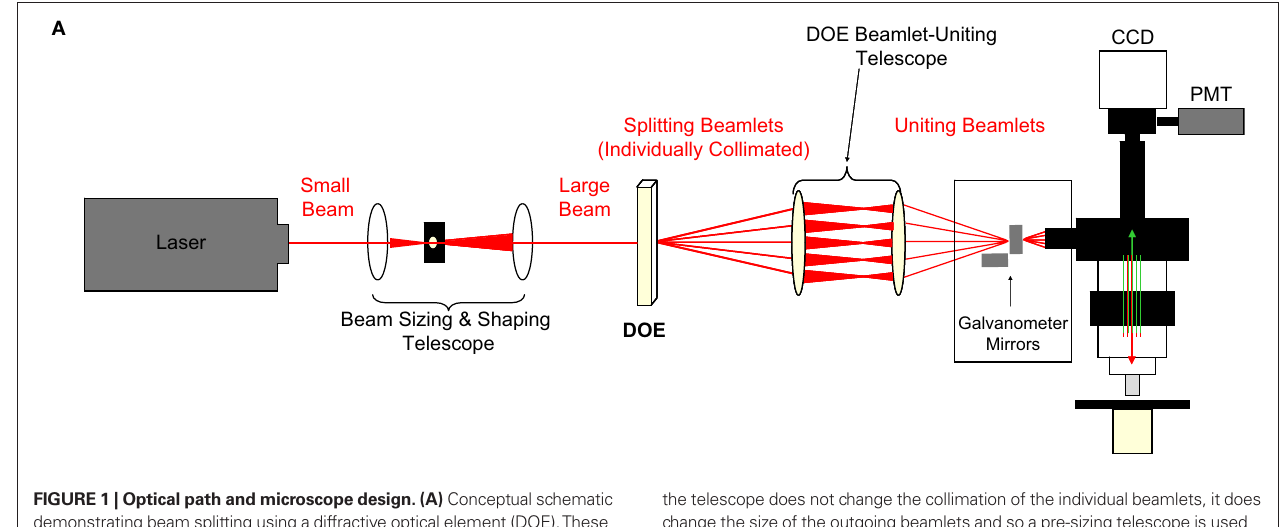
FIGURE 1 | Optical path and microscope design. (A) Conceptual schematic demonstrating beam splitting using a diffractive optical element (DOE). These beams are brought together onto the galvanometer mirrors which may scan and which transmit beams for exciting the sample underneath the objective. While